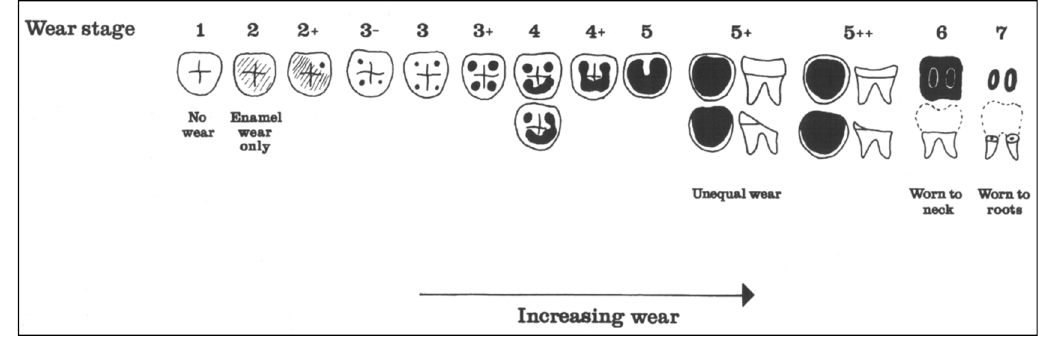
Figure 1. Brothwell classification of molar wear. White denotes enamel, black is exposed dentine [22].